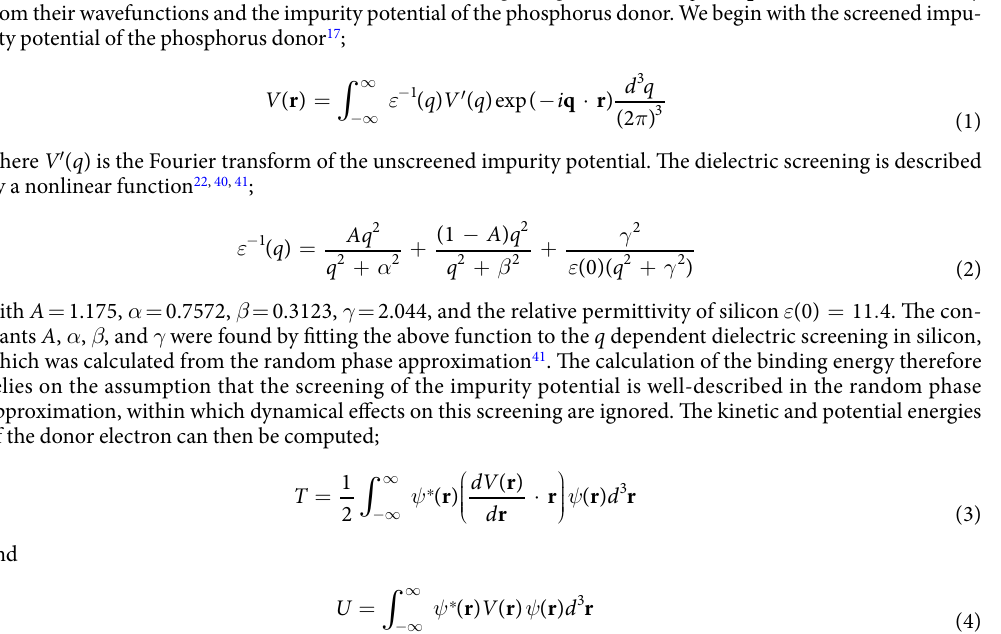
Figure 3. The energy levels of the s A 1 ( ) 10,648 atoms. The energy of the conduction band minimum (CBM) of bulk silicon is also shown for each supercell size. The conduction band minimum of the supercell containing 10,648 atoms has been set to energy